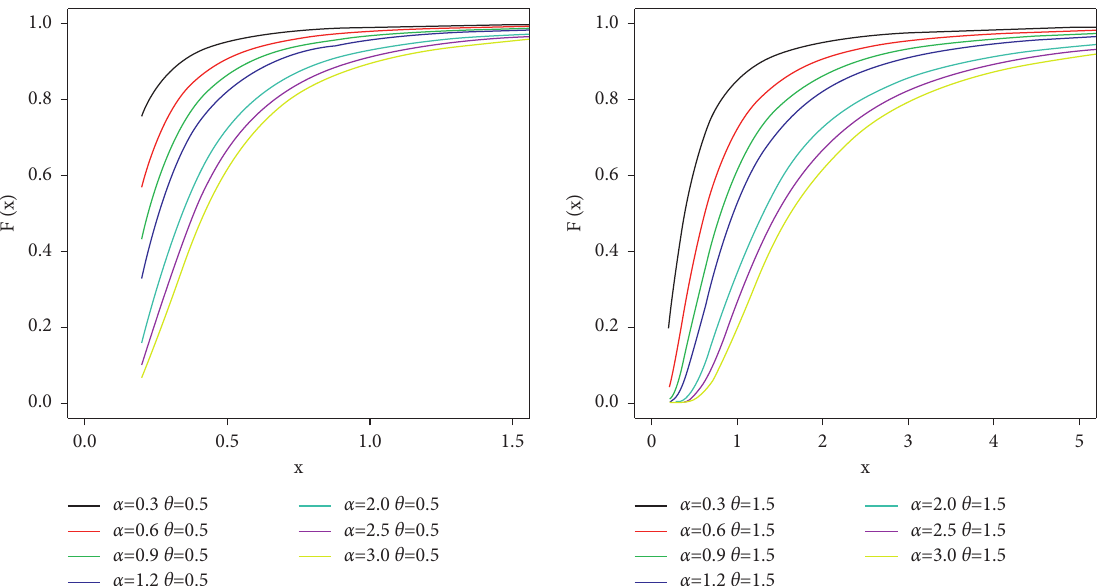
Figure 2: The cdf of the TLIL distribution for different values of parameters.